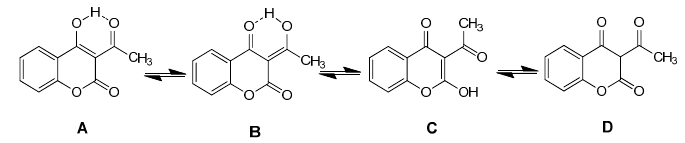
Scheme 2. Tautomers ( A – D ) of 3-acetyl-4-hydroxycoumarin 1 .